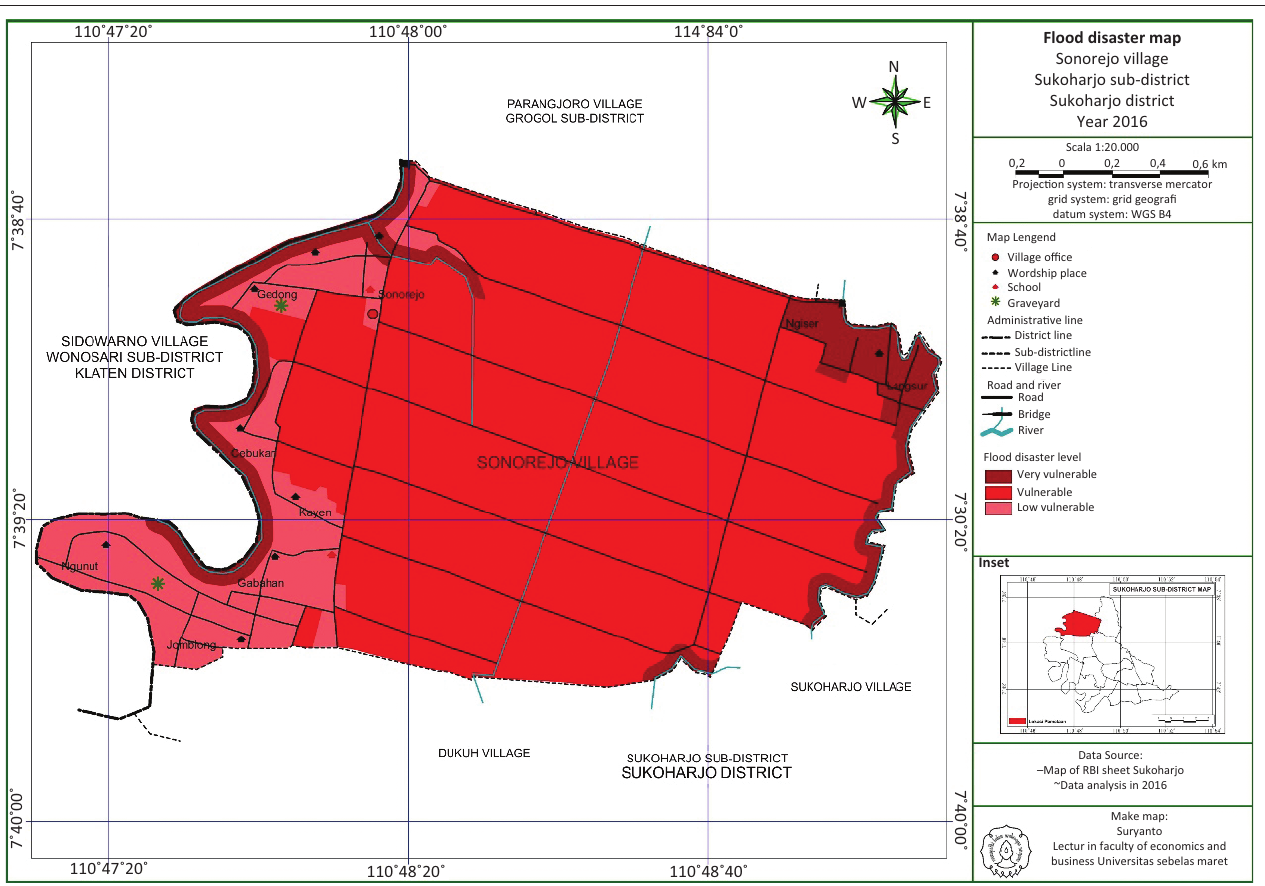
FIGURE 1: Mapping of flood-prone area in the Sonorejo